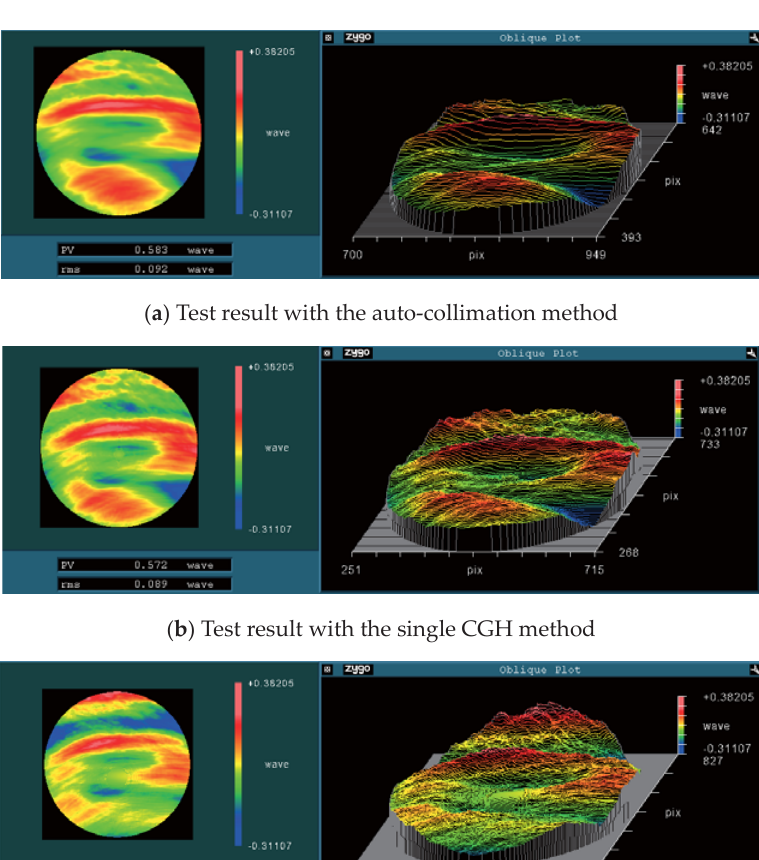
Figure 11. Photo of measuring this OAP via hybrid compensation (with customized fixture).